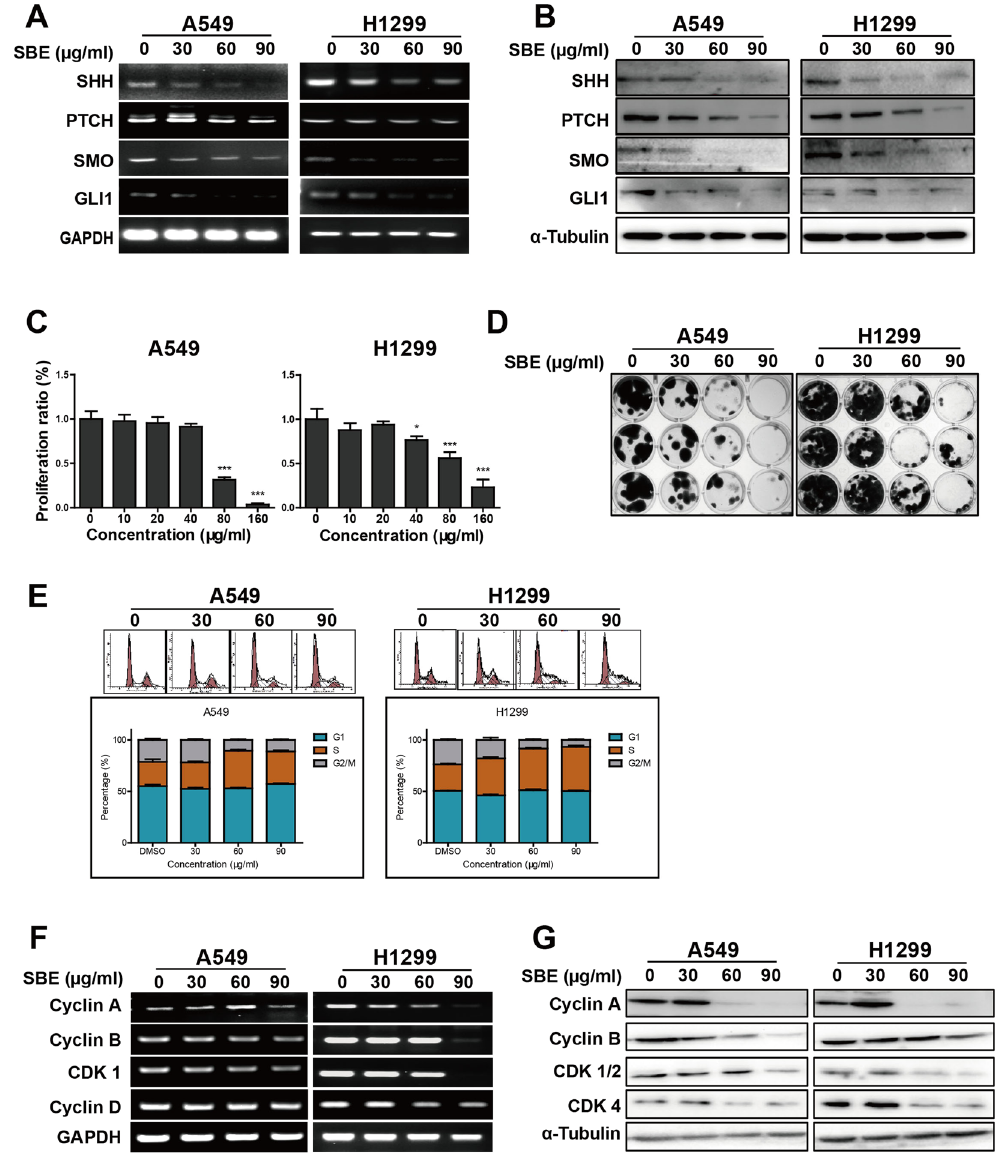
Figure 3. SBE inhibits cell proliferation and clonogenicity of NSCLC cells via selectively repressing SHH pathway and cell cycle checkpoint enzymes. ( A ) RT-PCR analysis demonstrating that SBE at 30, 60 and 90 μ g/ ml significantly decreased transcriptional activities of SHH pathway components (SHH, PTCH, SMO and GLI1) in A549 and H1299 cells. ( B ) Immunoblotting analysis demonstrating that SBE reduced protein level of SHH pathway components (SHH, PTCH, SMO and GLI1) in A549 and H1299 cells. ( C ) CCK-8 assay showing that SBE repress NSCLC cell proliferation in dose-dependent manner in A549( ≥ 80 μ g/ml) and H1299 ( ≥ 40 µ g/ml) cells tested by CCK-8. ( D ) SBE repressed clonal formation of cells in dose-dependent manner in A549 and H1299 cells from 30 to 90 μ g/ml. ( E ) Flowcytometry analysis demonstrating that SBE significantly induced G1/S phase arrest in A549 at 60 µ g/ml or higher and H1299 cells at 30 µ g/ml or more. Data were analyzed by ModFit software and presented as mean ± SD. ( F ) RT-PCR analysis demonstrating that SBE significantly inhibited transcriptional activities of cell cycle regulators (Cyclin A, Cyclin B, CDK1 and CDK4) in A549 and H1299 cells at 60 or 90 µ g/ ml concentration. ( G ) Immunoblotting analysis demonstrating that SBE decreased protein level of cell cycle regulators (Cyclin A, Cyclin B, CDK1 and CDK4) in A549 and H1299 cells at 60 or 90 µ g/ml